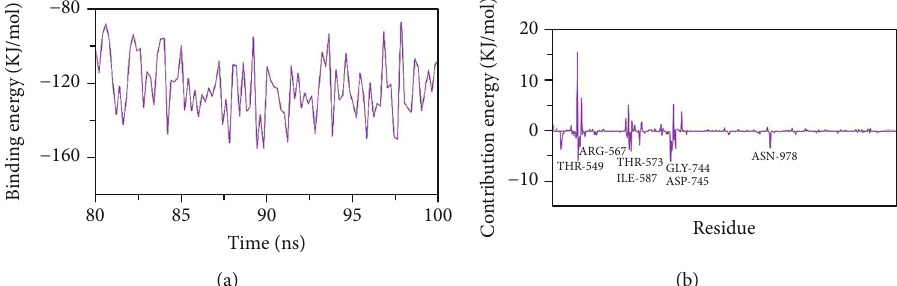
Figure 16: (a) Total binding energy plot of proanthocyanidin-B2 bound with 7T9K at 100-ns time frame. (b) Contribution energy plot with interacting amino